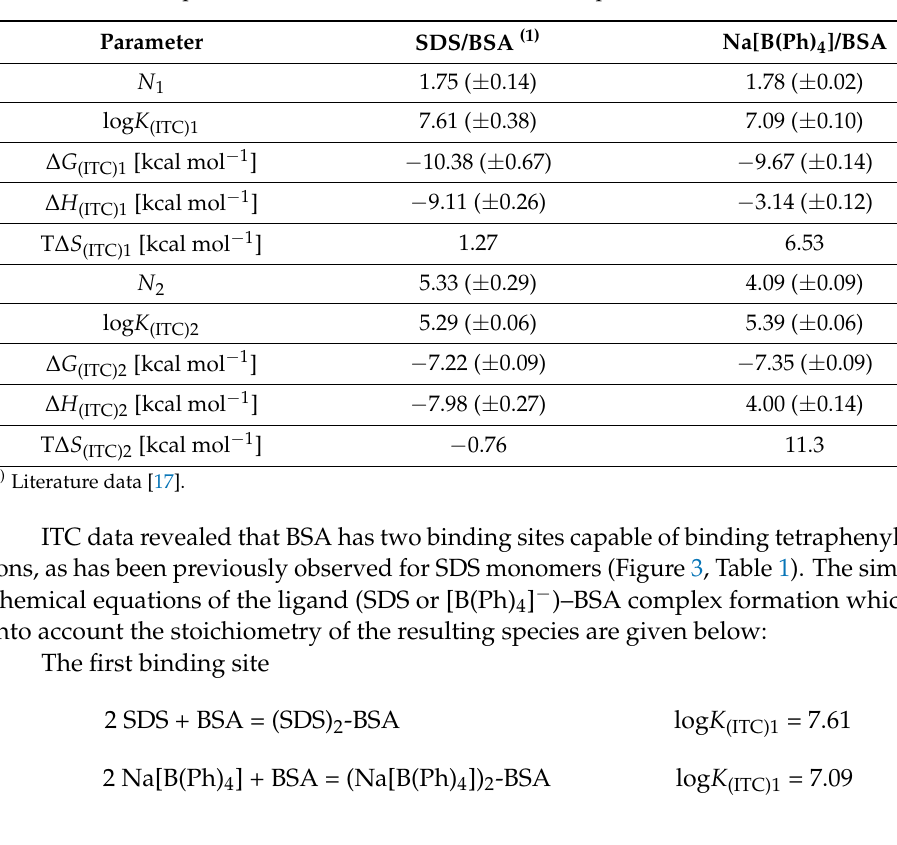
Figure 3. Calorimetric titration isotherms of the binding interactions between SDS and BSA (LEFT) and Na[B(Ph) 4 ] and BSA (RIGHT) in the10 mM Caco buffer of pH 7, at 298.15 K. Table 1. The conditional thermodynamic parameters of SDS and Na[B(Ph) 4 ] binding to BSA (standard deviation values in parentheses) in the 10 mM Caco buffer of pH 7, at 298.15 K.